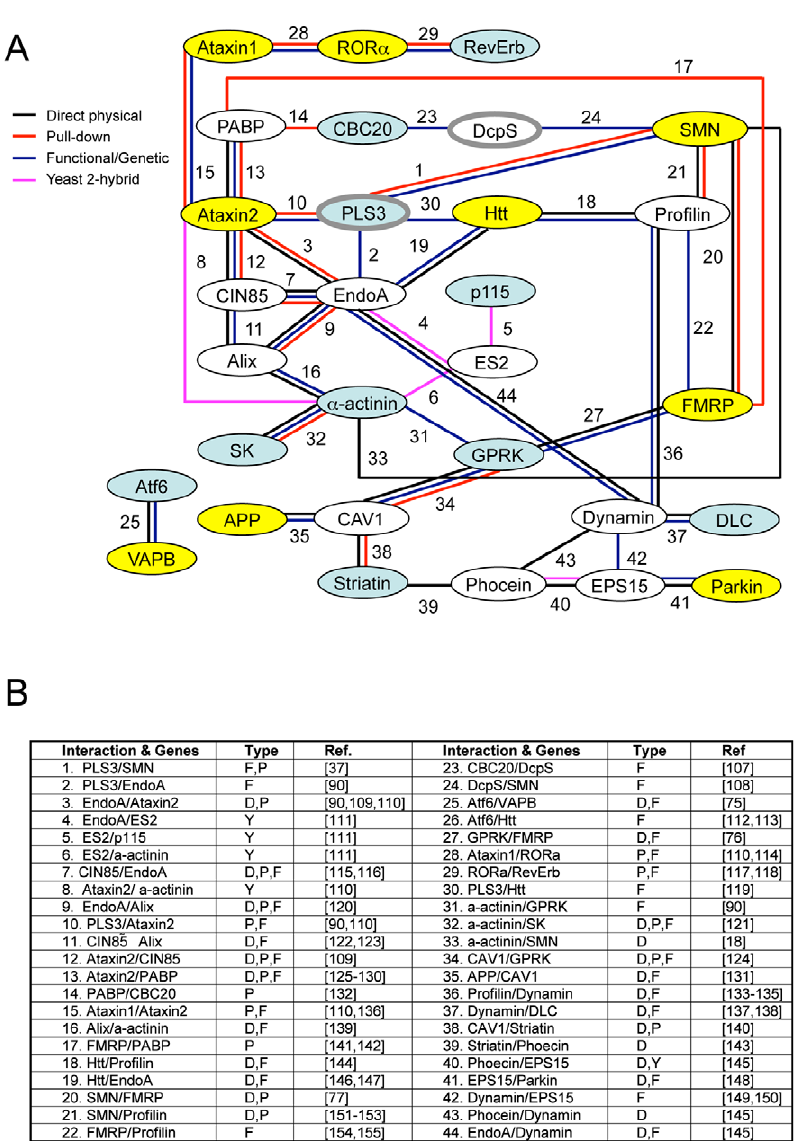
Figure 7. Interaction map of SMN modifier genes. A) Numerous published physical and/or functional interactions were found in the literature that connect many invertebrate SMN modifier genes. The names of vertebrate genes are used in the figure, but interactions are drawn from literature in any animal species. Each type of interaction is represented by different colors of connecting lines and references are provided in the table in part B. Not all interactions are indicated including interactions of FGF, TGF-beta and neuropeptide signaling pathways with endocytosis/cytoskeletal pathways, dynein interactions with APP [101] and possible connection between VAPB, the ALS8 locus, and SK channels through riluzole [102–106]. The interaction analysis here is not exhaustive and additional interactions may exist. B) The type of interaction is indicated in the table [107–155]: P pull-down, Y yeast 2-hybrid, F functional/genetic, D direct physical interaction. Genes shaded in blue are cross-species invertebrate modifiers; genes shaded in yellow are mammalian genes whose perturbation can cause neurodegeneration; genes outlined in grey are SMA modifiers in drug studies or in patients. Genes pertinent to endocytosis include CIN85, EndoA, Alix, PLS3, CAV1, GPRK, Ataxin2, Profilin, EPS15, Phocein, Dynamin, and Striatin; genes pertinent to RNA processing include PABP, CBC20, DcpS, SMN, and FMRP. Combined, our results and published studies support a model in which endocytosis and RNA translational control pathways are physically and functionally coupled [92,93]. In normal animals, coupling of these seemingly disparate pathways may help coordinate synaptic activity and protein synthesis in the neuromuscular